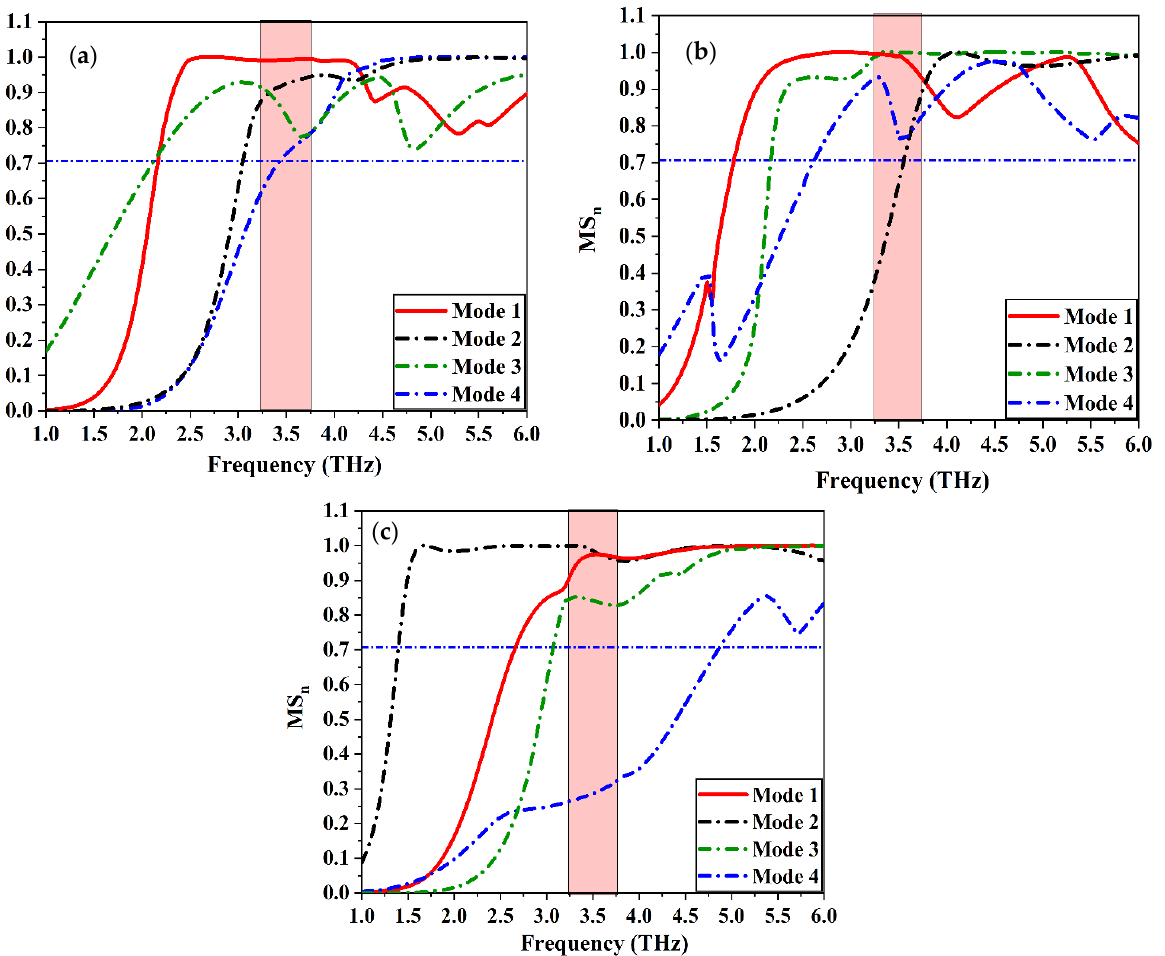
Figure 10. Model Significant of the proposed MIMO configurations ( a ) Ant. A, ( b ) Ant. B, and ( c ) Ant. C .